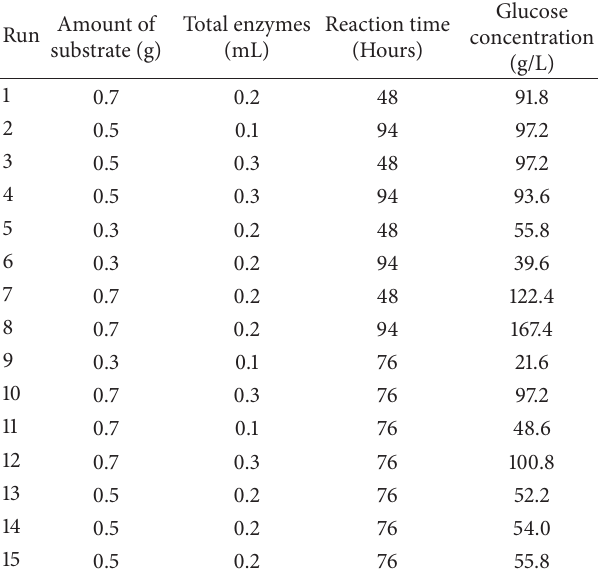
Table 2: Effect of different parameters on enzymatic hydrolysis of OPEFB